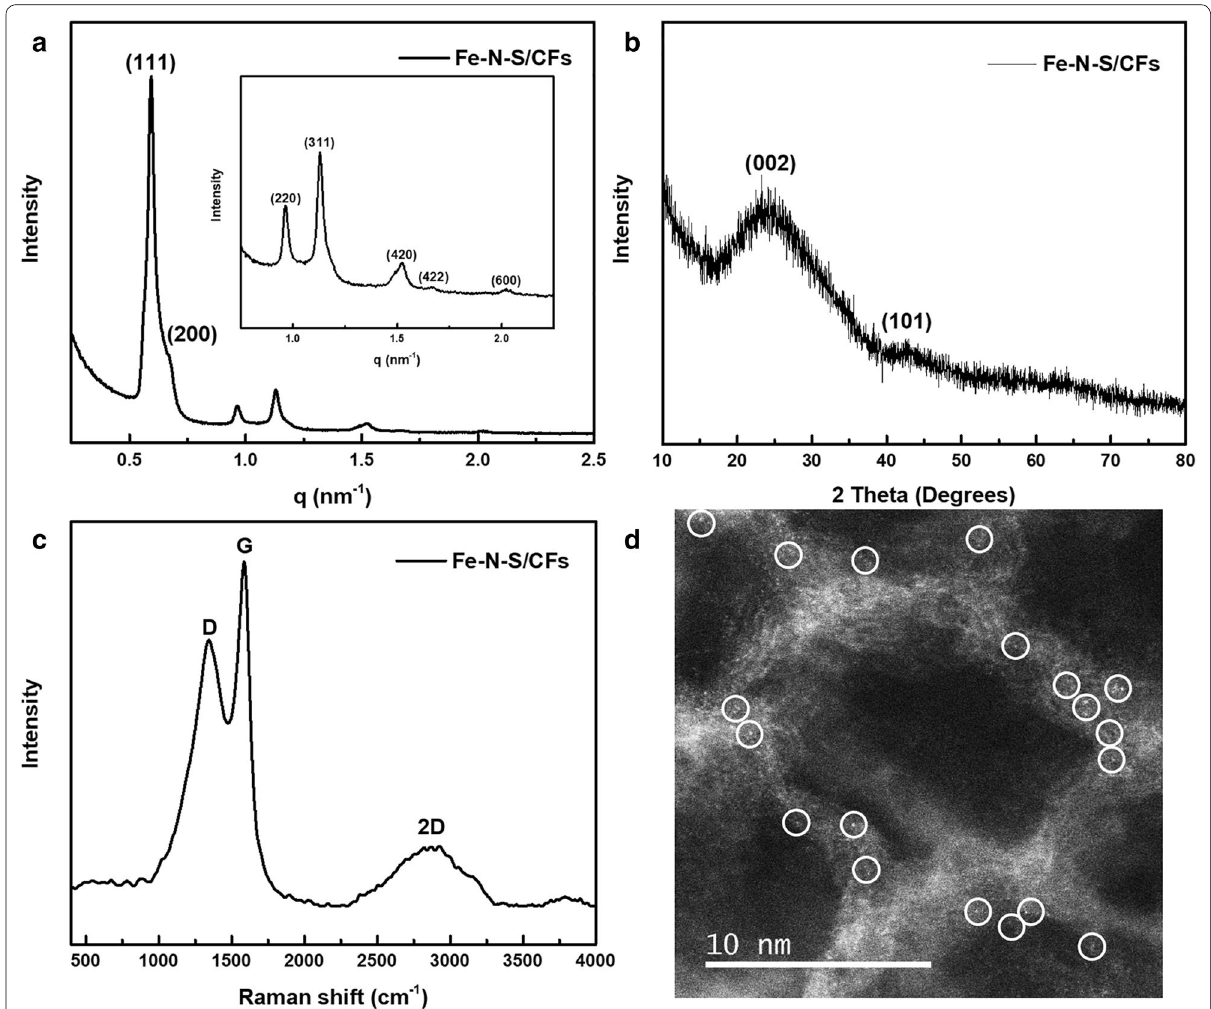
Fig. 2 a SAXS pattern of highly ordered Fe–N–S/CFs and the enlarged region between 0.75 and 2.25 nm − 1 (insert). b XRD pattern and c Raman spectrum of Fe–N–S/CFs. d Representative Cs-corrected HAADF-STEM image of Fe–N–S/CFs (the bright spots, assigned to Fe atoms, are circled in the